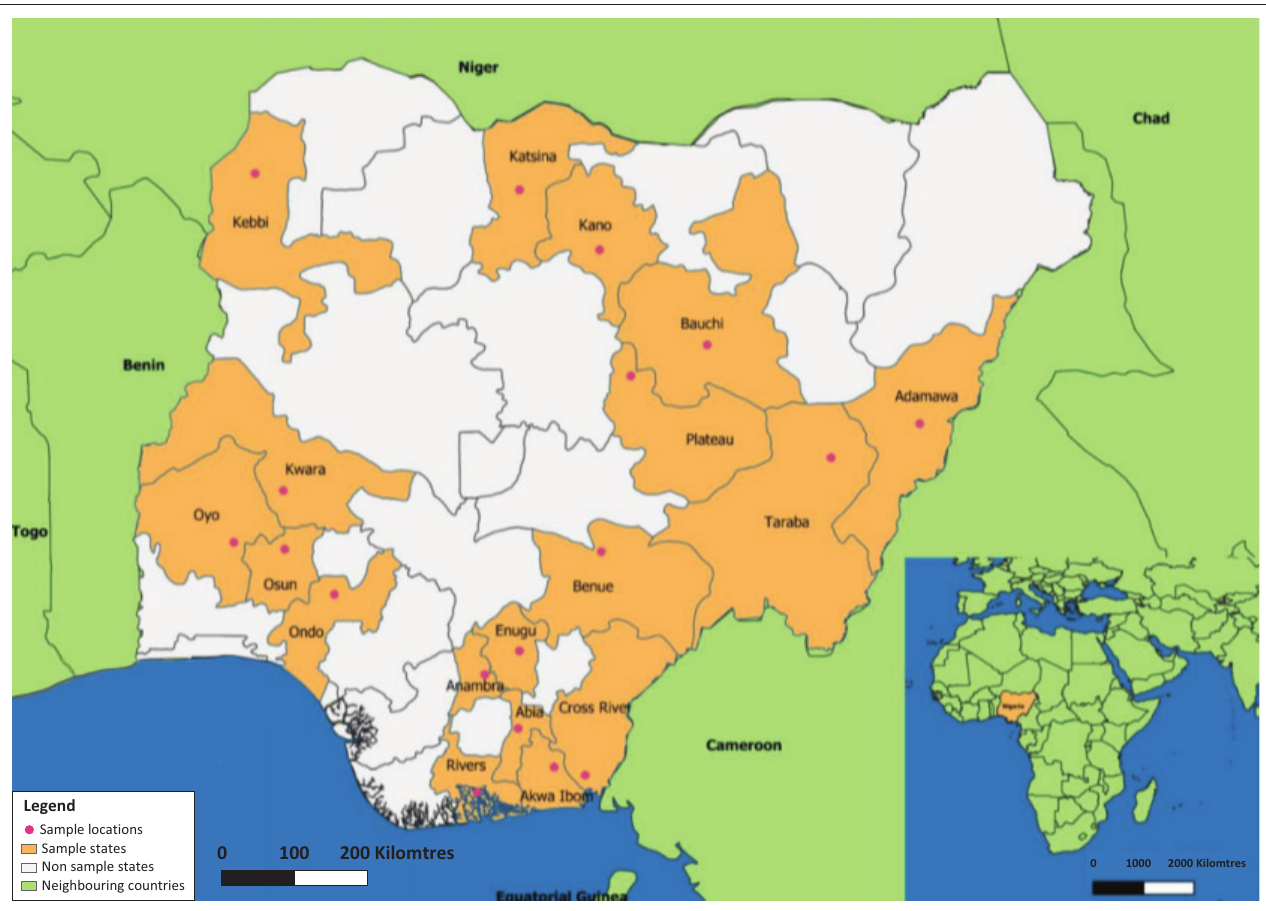
FIGURE 1: Sampling locations in different states of Nigeria over the period 2017–2018.